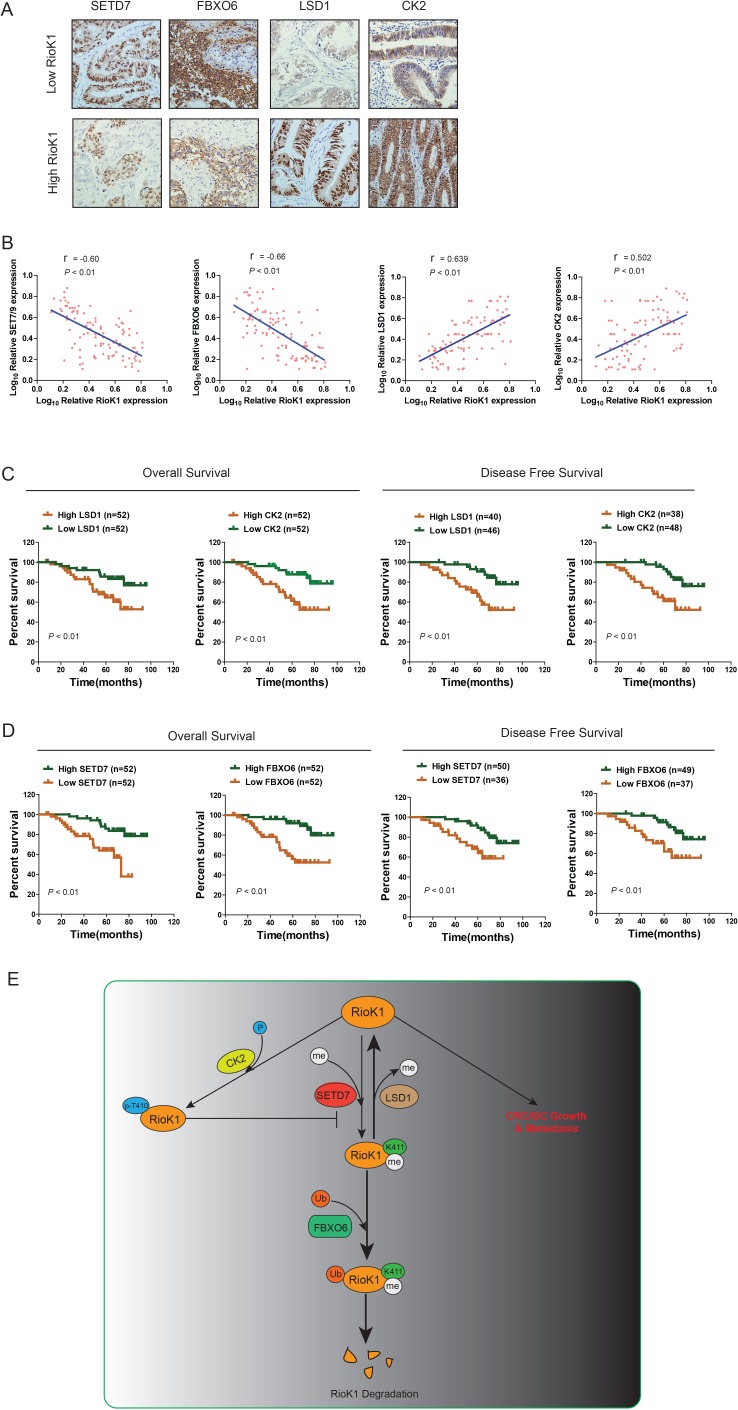
Clinical relevance of RIOK1, SET7/9, LSD1, FBXO6 and CK2 Expression in patients with CRC.(A) Immunohistochemical staining of 104 human CRC for LSD1, CK2, SET7/9, and FBXO6 was performed. Representative photos of stains are shown in the groups with high (staining score, 5–8.0) and low (staining score, 0–4.0) expression of RIOK1. (B) Correlation between RIOK1 expression and LSD1, CK2, SET7/9, and FBXO6 expression in 104 clinical samples, respectively. (C and D) Kaplan–Meier plots of the overall survival and disease free survival in the patients (n = 104) with CRC in the groups with high (staining score, 5–8.0) and low (staining score, 0–4.0) expression of LSD1, and CK2 and SET7/9 and FBXO6. (E) A proposed model illustrating that the RIOK1 methyl-phospho switch by SET7/9- CK2-LSD1 axis dictates the stability of RIOK1 and its role in CRC and GC growth and metastasis.